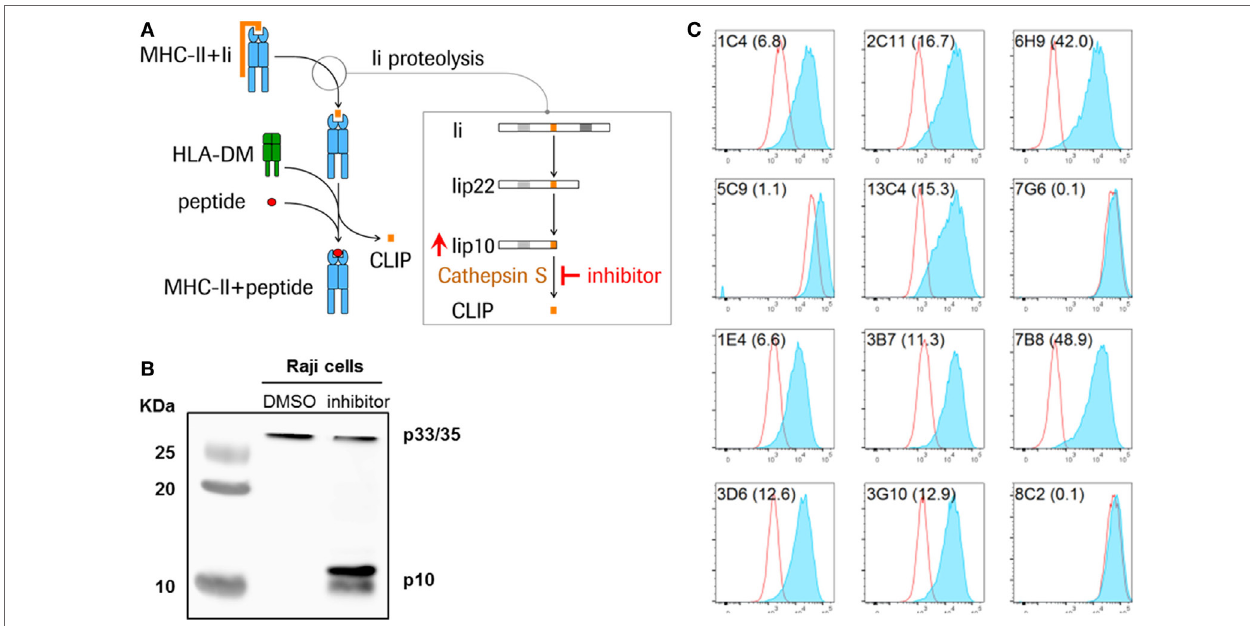
FIgURe 1 | Detection of Lip10 accumulation in RAJI B cell line upon cathepsin S-specific inhibition. (A) Schematic diagram of invariant chain (Ii) proteolytic removal as part of the major histocompatibility complex (MHC) class II presentation pathway. Inhibition of cathepsin S activity leads to an accumulation of cathepsin S substrate Lip10 in professional antigen-presenting cells. (B) Lip10 accumulation after cathepsin S inhibition was detected by western blot using an anti-CD74 antibody in RAJI cells incubated for 20 h with cathepsin S-specific inhibitor RO5459072. (C) Twelve antibody clones raised in rabbits against the C-terminal end of Lip10 were tested for the ability to detect intracellular Lip10 accumulation by staining RAJI cells incubated for 20 h with RO5459072 in a flow cytometry-based assay. Lip10 median fluorescence intensity (MFI) is displayed for DMSO-treated (red line) and RO5459072-treated (solid blue) RAJI cells. The stain index, calculated for each clone, with (MFI of cathepsin S inhibitor-treated cells − MFI of DMSO-treated cells)/SD of DMSO-treated cells, is displayed in parenthesis after each clone name.